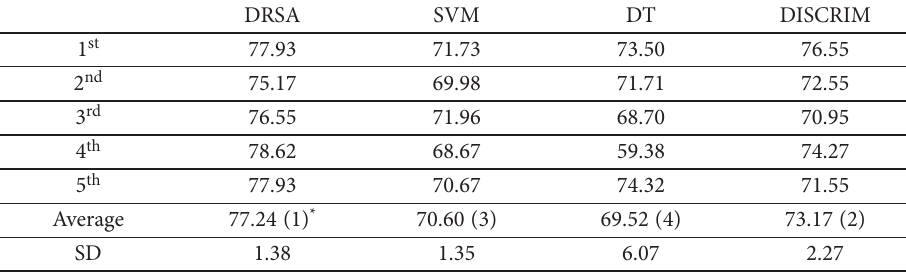
Table 2. Classification accuracy of the training set (unit: